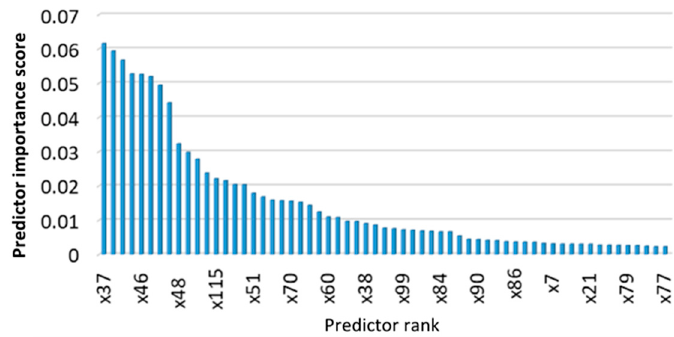
The raw sensors (136 sensors) are given as the input in the extra-tree classifier. The top 61 are selected as the optimal sensors necessary to predict turbine motor fault. Figure 19 presents the predictor importance score of the selected sensors. X37 (bearing#2 vibration- 2Y) is selected as the most sensitive sensor variable with a predictor importance score of score of 0.062. 0.062.